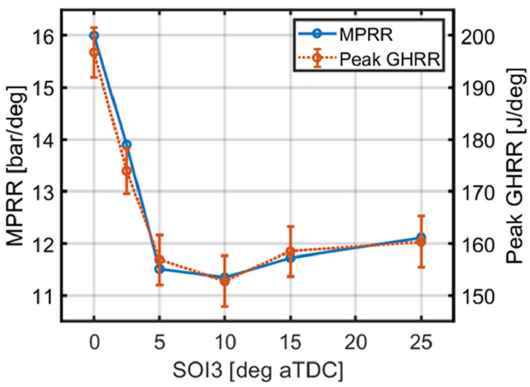
Figure 5. Maximum pressure rise rate (MPRR) and peak gross heat release rate (GHRR) vs. mixing- controlled start of injection (SOI3) timing.